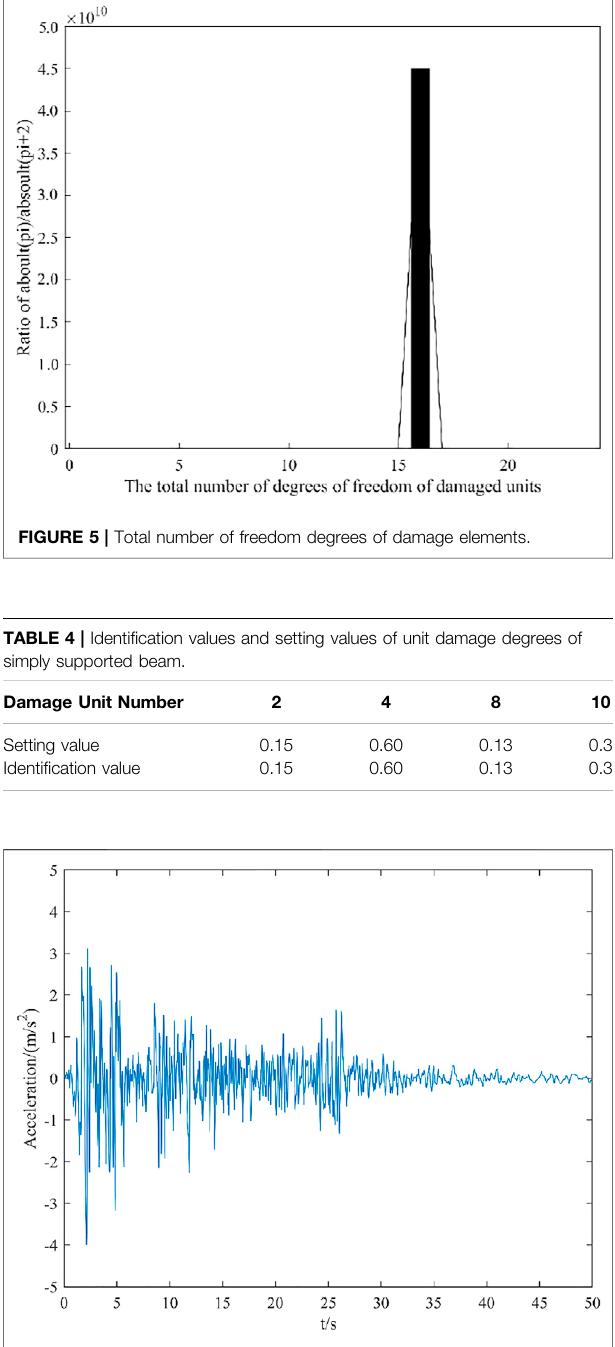
FIGURE 6 | EL Centro seismic wave time history